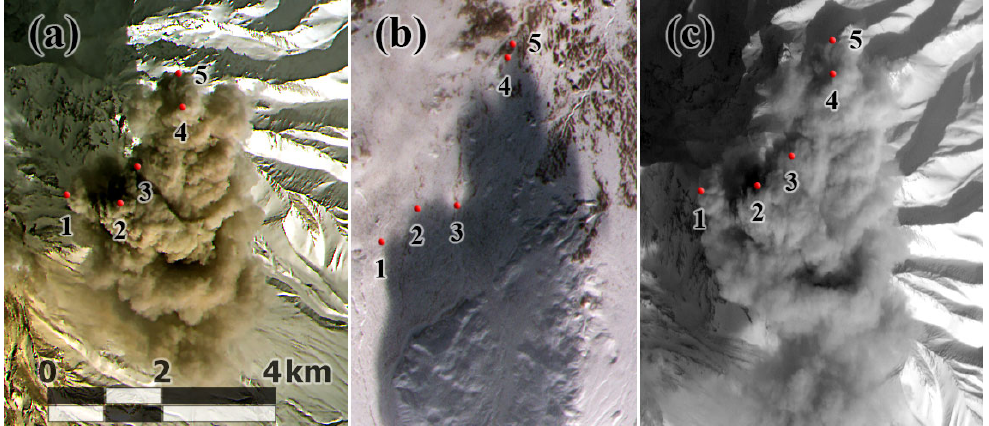
Figure 19. Shiveluch volcano ash plume features identified and measured in the nadir- and backward- looking bands. The time elapsed between nadir and backwards acquisitions was 55.4 s: ( a ) Features on the nadir-looking bands; ( b ) Corresponding shadows on the nadir-looking bands; and ( c ) Features on the backward-looking band.